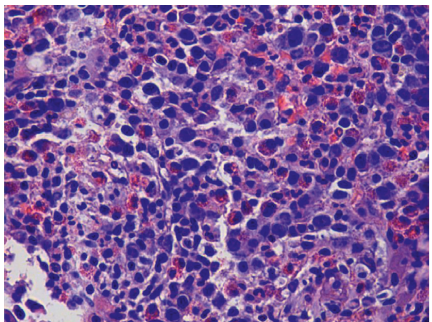
Figure 2: Bone marrow with hypercellularity and increased mast cells.